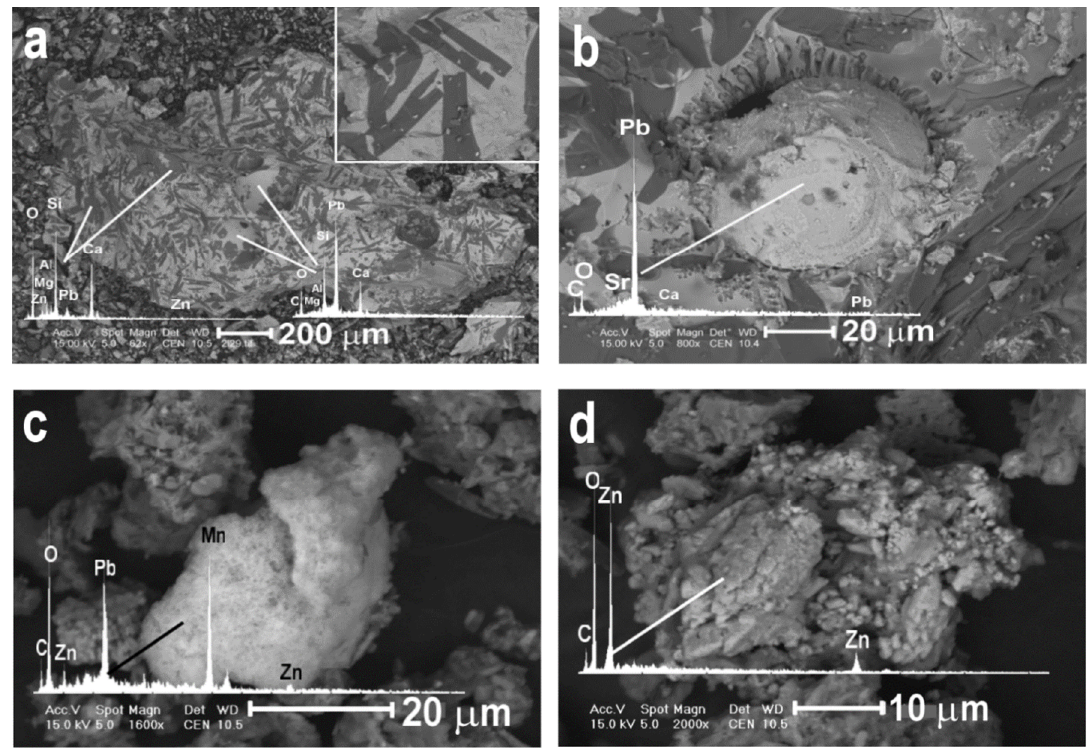
Figure 4. BSE images of metal components in the topsoil. Site archaeological investigations of medieval Ag-Pb smelting operations in Łosień: ( a ) lead slag in skull form ( b ) lead slag in Ca-Aluminosilicate matrix. Site Zn-Pb processing operation in Kawa: ( c ) Aggregate Pb, Zn carbonate and Mn oxide ( d ) Zn carbonate.